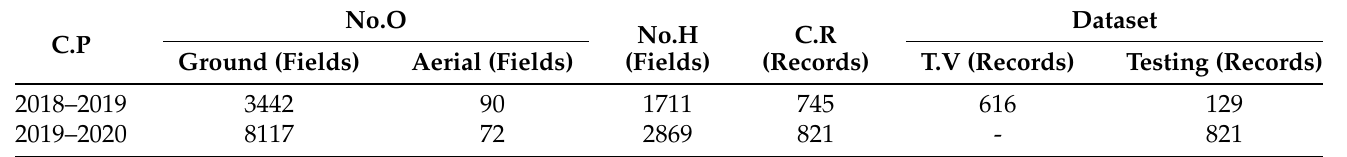
Table 2. Information on the field surveys and the resulting data used.